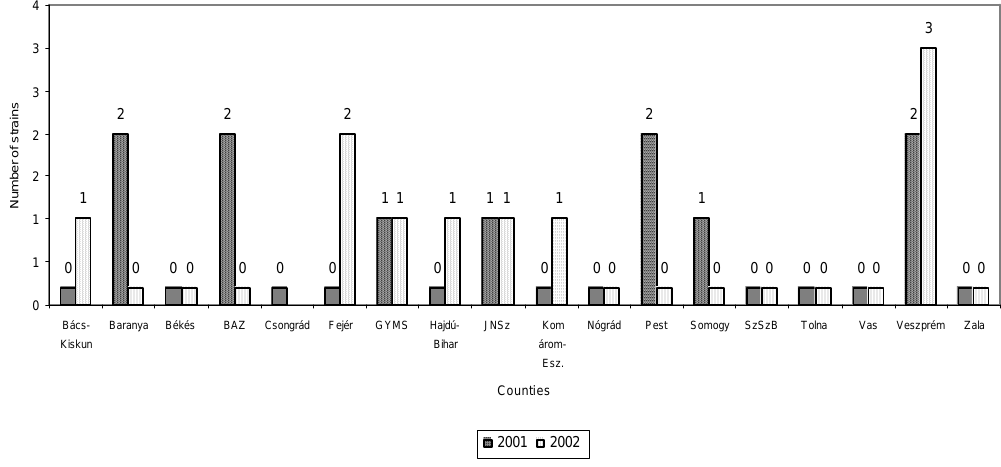
Figure 14. Source of the Hungarian vancomycin-resistant Enterococcus durans strains at county level in 2001 (n=13) and 2002